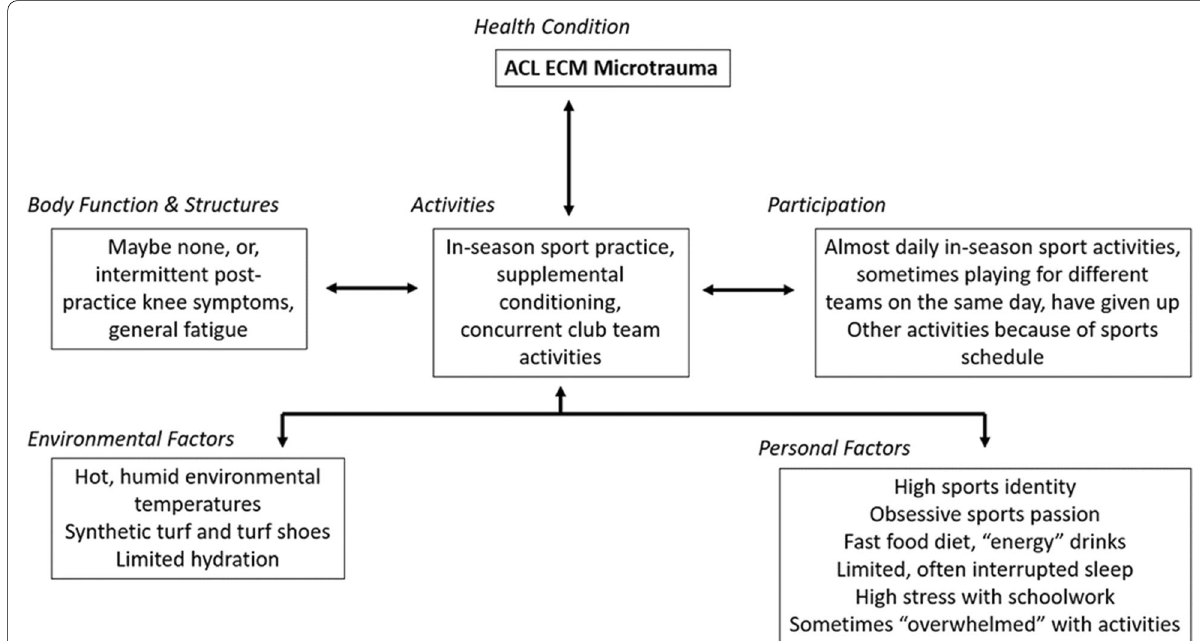
Fig. 1 ACL extracellular matrix microtrauma example within the International Classification of Functioning, Disability and Health (ICF) framework [107]. Many youth and adolescent sport athletes display variable combined factors that lead to ACL microtrauma